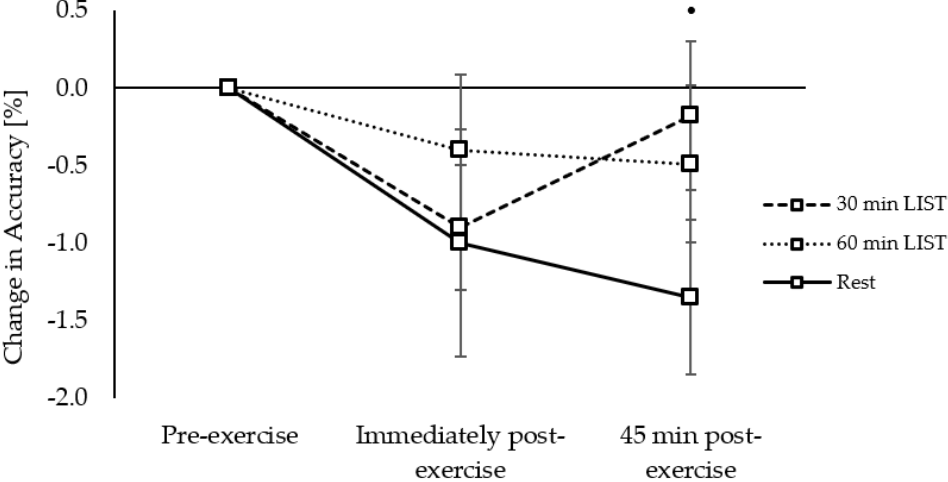
Figure 10. Change in accuracy across the morning on the 30 min LIST, 60 min LIST, and resting control trials on the congruent level of the Flanker task. Tendency for greater accuracy following 30 min LIST vs. rest •; p = 0.095.